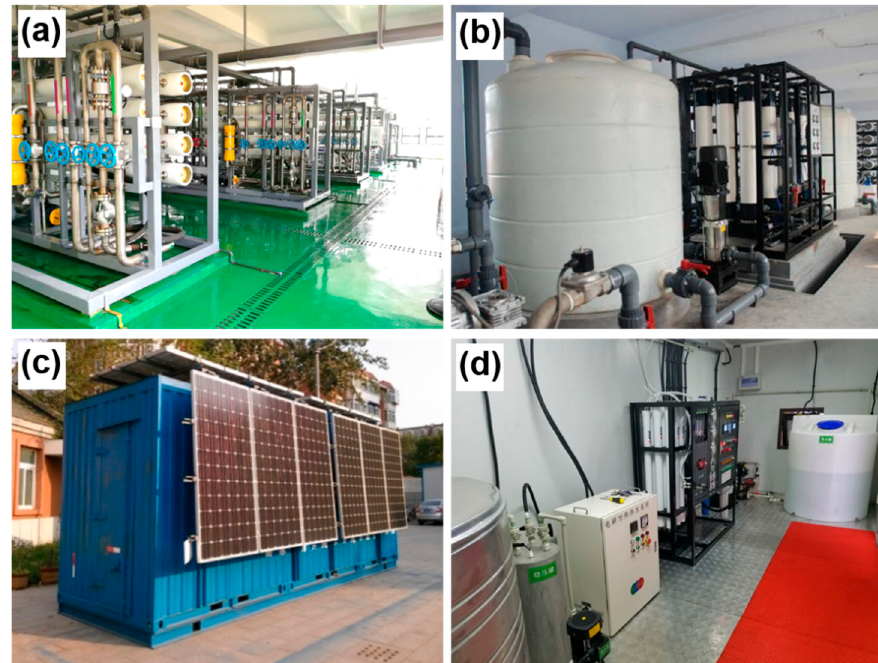
Figure 9. Photographs of some different desalination devices from ISDMU. ( a ) Yongxing (capacity, 1000 m 3 /d). ( b ) Lingshan (capacity, 300 m 3 /d). ( c ) The all-in-one system (wind, solar, oil, desalination, and intelligent control integrated into one system). ( d ) The South Pole (the capacity of 5 m 3 /d).